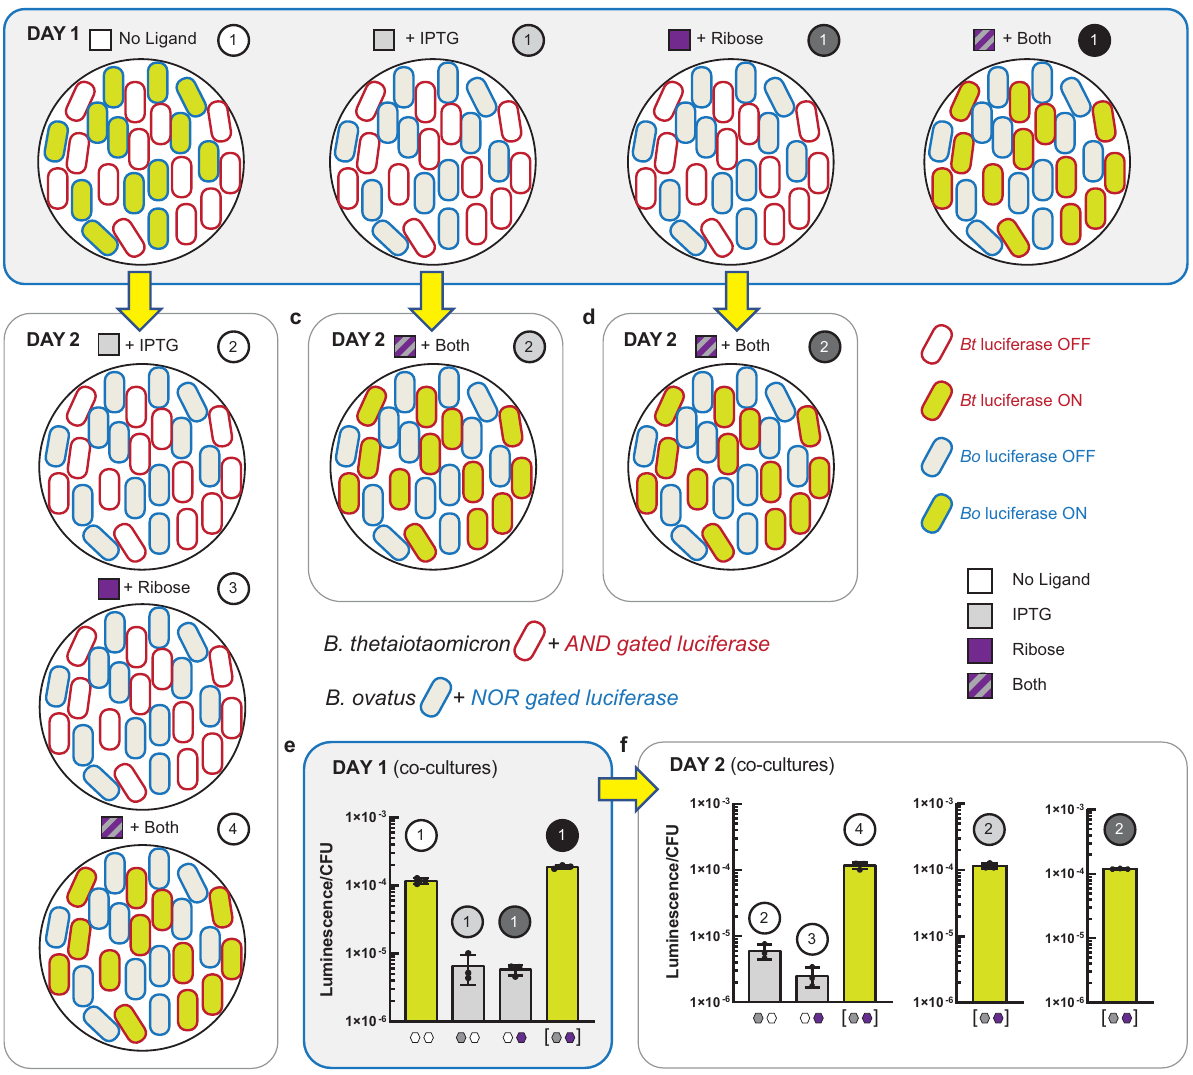
Fig. 7 Sequential programming in co-culture. a Co-culture composed of B. thetaiotaomicron and B. ovatus harboring different logic gates. B. thetaiotaomicron integrated with an AND gate was grown in the same TYG culture as B. ovatus integrated with a NOR gate (both gates regulating luciferase expression). Co- cultures were grown in the presence of all combinations of inducers (each at a fi nal concentration of 10 mM) yielding four total cultures which were independently assayed for luciferase activity (Methods). b Sequential programs derived from the “ No Ligand ” culture in a . The initial co-culture was used to seed fresh media containing additional inducers (i.e., IPTG, ribose, or both ligands). These new co-cultures were grown and assayed for luciferase activity ( f , left bar chart). c Sequential program derived from the “ + IPTG ” culture in a . The initial co-culture was used to seed fresh medium containing both ligands. This new co-culture was subsequently assayed for luciferase activity ( f , middle bar chart). d Sequential program derived from the “ + Ribose ” culture in a . The initial co-culture was used to seed fresh medium containing both ligands. This new co-culture was subsequently assayed for luciferase activity ( f , right bar chart). e Luciferase activity of co-cultures on day 1. Numbered circles correspond to the co-cultures illustrated in a . f Luciferase activity of co-cultures on day 2. Numbered circles correspond to the co-cultures illustrated in b – d . Source data are provided as a Source Data fi le. Data represent the average of n = 3 biological replicates. Error bars correspond to the SEM of these agar supplemented with gentamicin and either erythromycin for pNBU2 constructs 3' end of a tRNA-Leu gene in Bacteroides genomes. Similarly, the pNBU2 vector or tetracycline for pNBU1 constructs. Resultant colonies were picked into TYG harbors intN2 which mediates site-speci fi c recombination of the attN2 site of pNBU2 and one of two attB2 sites located at the 3' ends of tRNA-Ser genes in Bacteroides genomes. Simultaneous insertion of pNBU2 vectors at both sites was never observed, likely due to the necessity of having at least one functional tRNA- Ser gene. Thus, only single copy genetic circuits were stably delivered into Bac- jugation procedure was performed as described above. teroides genomes. Donor cultures of E. coli S17-1 ƛ pir transformed with the appropriate pNBU1 or pNBU2 construct and recipient cultures of Bacteroides were separately grown to OD600 ~0.5. For all strains except B. fragilis , 1 ml of donor culture and 1ml of recipient culture were pelleted by centrifugation (5000× g, 5min.) separately and resuspended in 1 ml of PBS. This step was then repeated for a second wash. The cultures were then mixed at a ratio of 1:10 (donor:receiver) and pelleted again by centrifugation. Cells were resuspended in 100 μ l PBS and spot plated on a BHI agar plate. The mating lawn was grown aerobically at 37 °C for >16h before being scraped into 3ml of PBS. Serial dilutions were plated on BHI